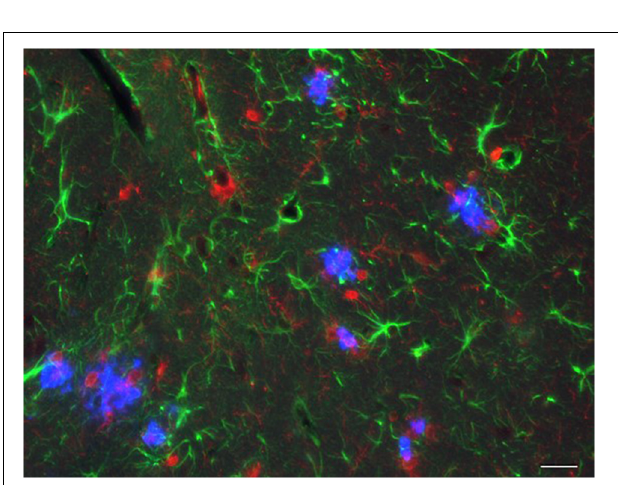
FIGURE 5 | AD pathology in the hippocampus of a 3rd generation model mouse. A 12-month-old App NL − F X Psen1 P 117 L / WT mouse was analyzed by immunohistochemistry. Blue: A β plaques; red: microglia; green: astrocytes. The bar indicates 25 µ